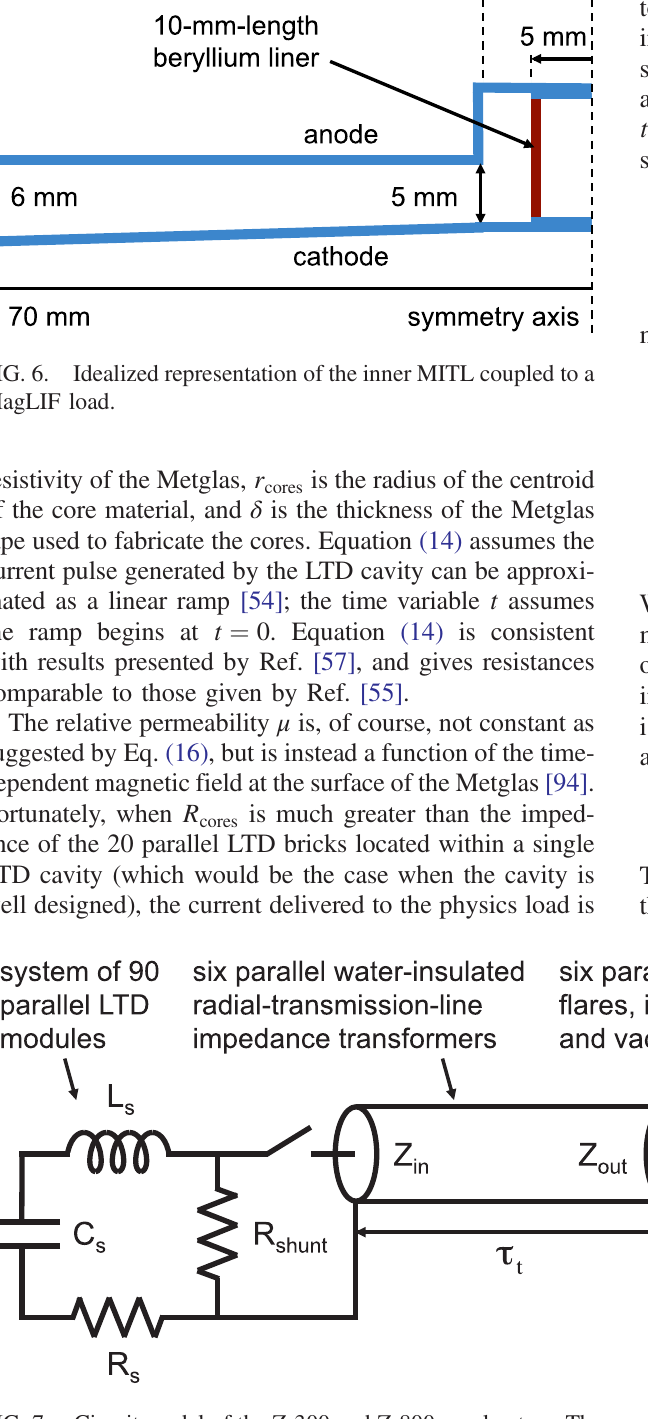
is the shunt resistance of the LTD system; Z and Z are the shunt in out is the total stack is the inductance of the six parallel MITLs; L is the MITLs con is the inner-MITL inductance; L is the load inductance; and R is a inner load inner ð t ¼ 0 Þ ¼ 0 . The so that L load load